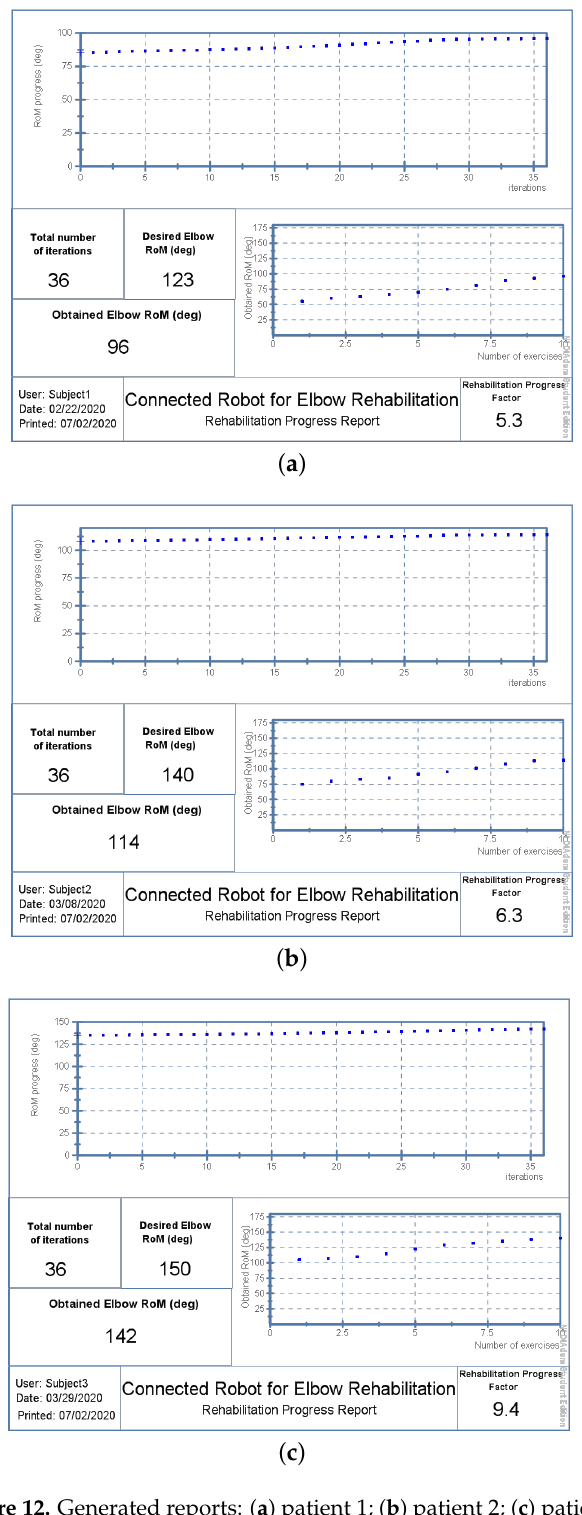
Figure 12. Generated reports: ( a ) patient 1; ( b ) patient 2; ( c ) patient